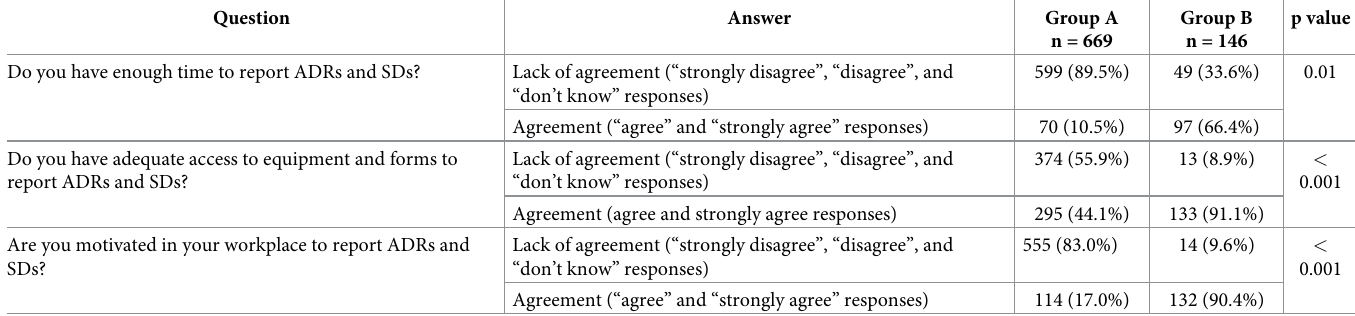
Table 3. Responses of the Polish (group A) and the American (group B) nurses to the questions concerning the assessment of their workplace in terms of having time at their disposal, unlimited access to equipment, and motivation provided by their employer to report ADRs and